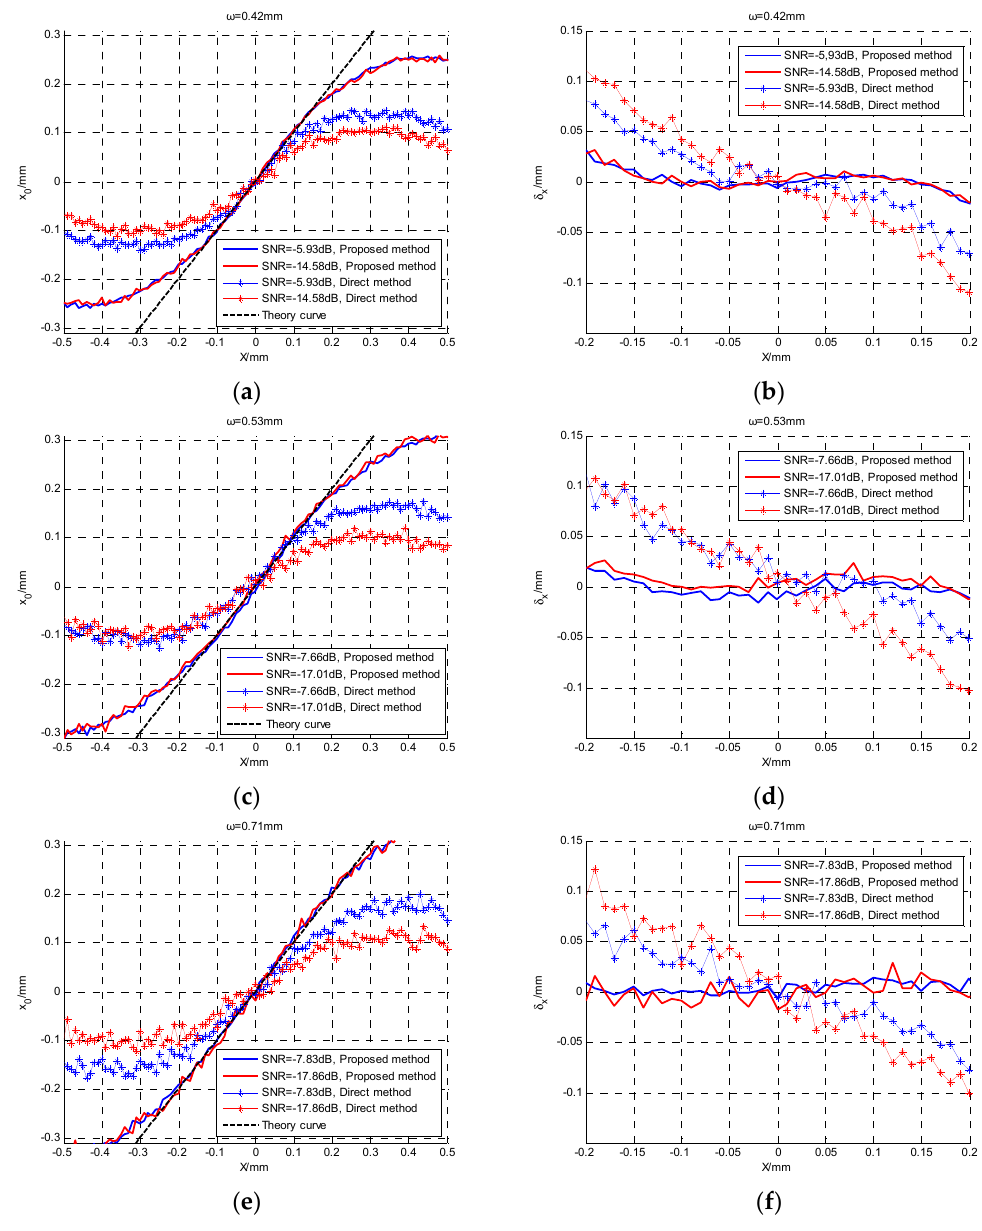
Figure 6. The calculated x coordinate curves and absolute errors of the two methods. ( a ) The calculated x coordinate curves when ω = 0.42 mm; ( b ) the absolute errors when ω = 0.42 mm; ( c ) the calculated x coordinate curves when ω = 0.53 mm; ( d ) the absolute errors when ω = 0.53 mm; ( e ) the calculated x coordinate curves when ω = 0.71 mm; ( f ) the absolute errors when ω = 0.71 mm.